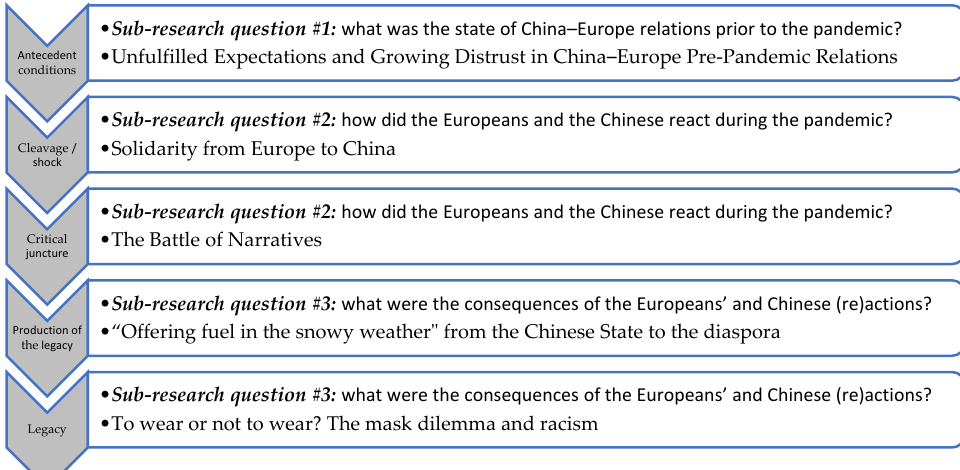
Figure 1. Critical juncture-framed research questions.